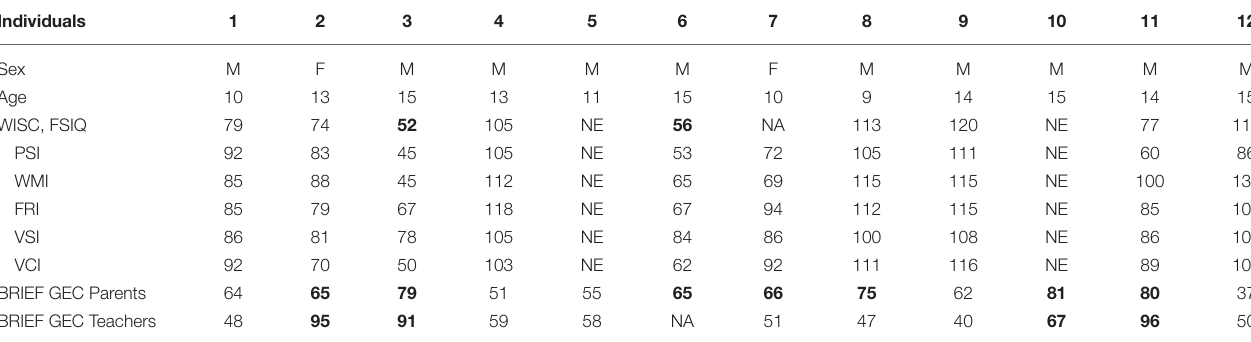
TABLE 4 | Neuropsychological profiles for each child and adolescent included in the study (n = 12).